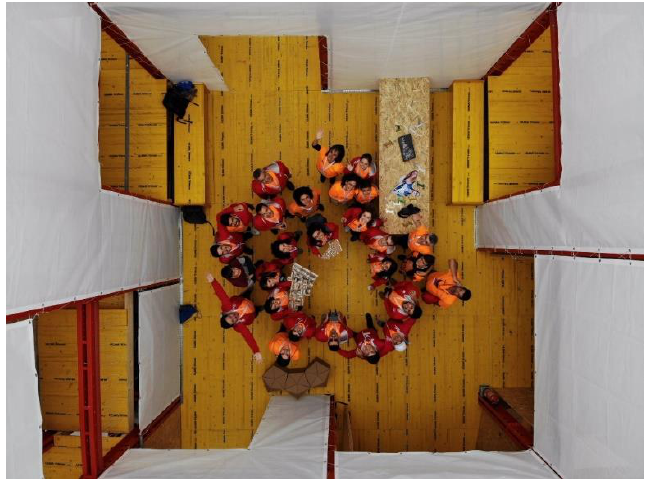
Figure 5. Survey. Figure 5.